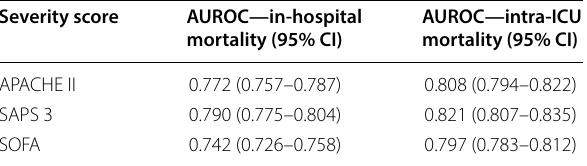
Table 3 Severity score’s area under the receiver operating characteristic (AUROC) curves for hospital and